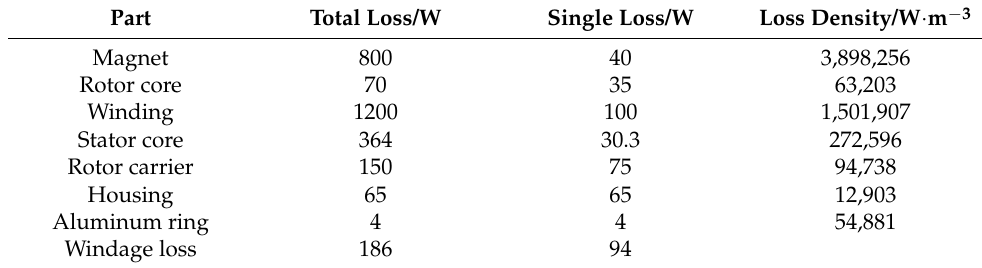
Table 2. Losses of the YASA